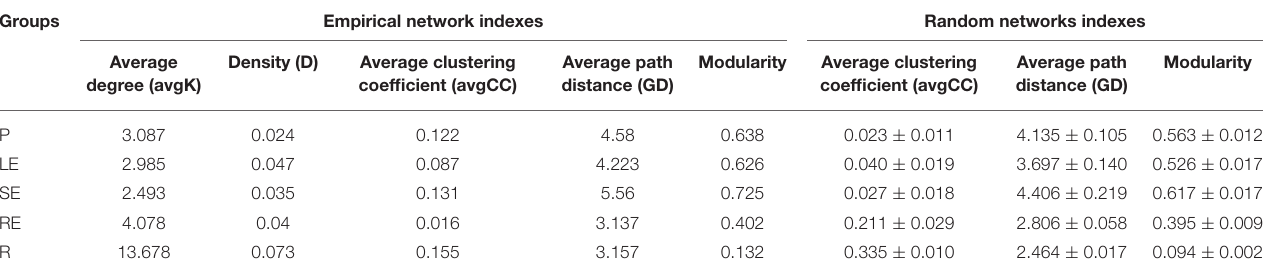
TABLE 2 | Topological properties of the empirical ecological networks at different ecological compartments in comparison to the random networks.